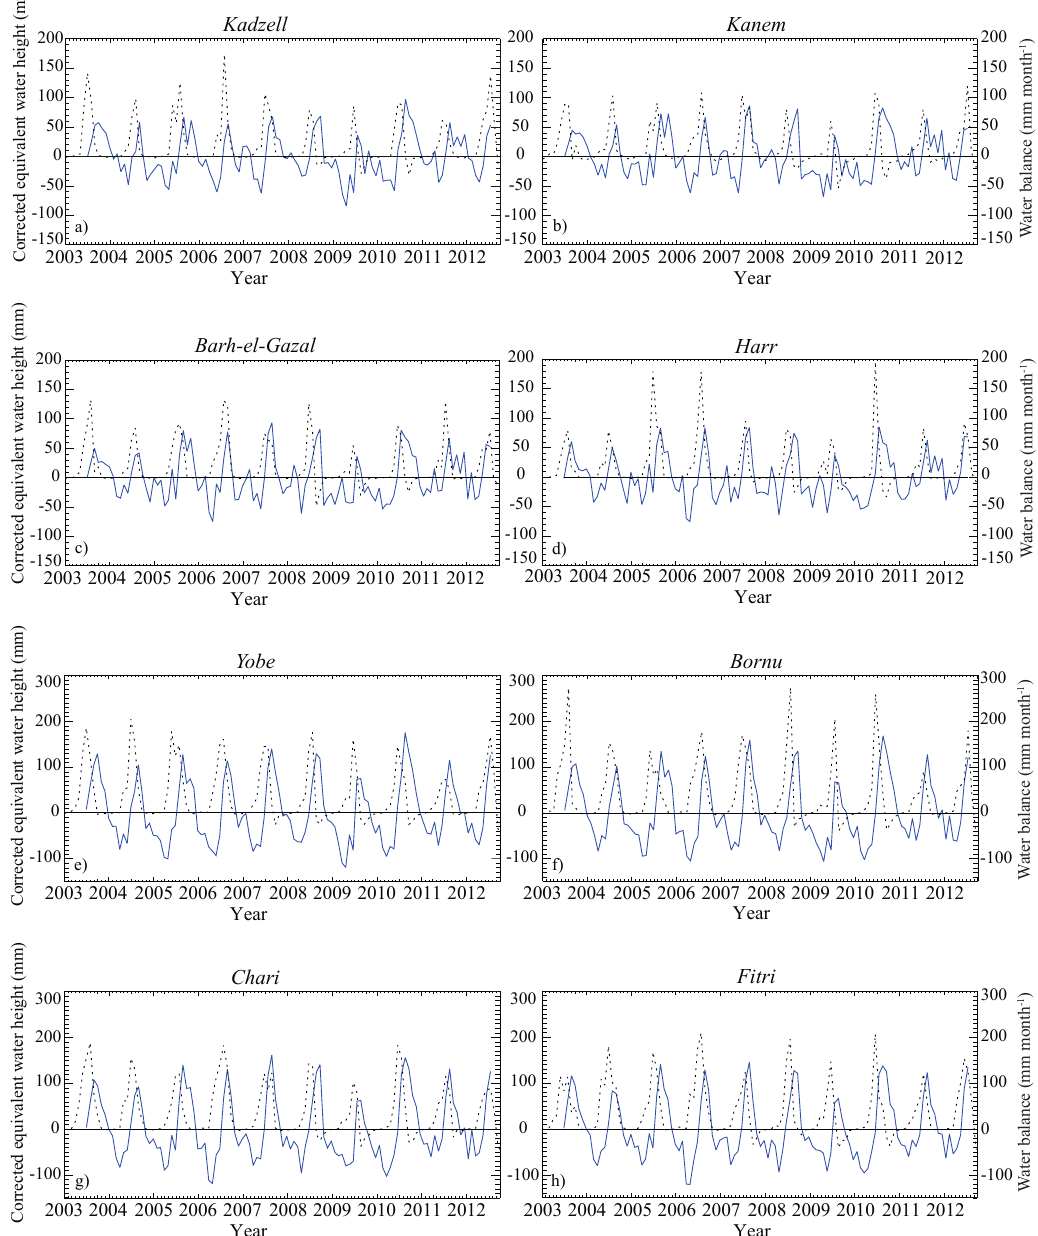
Figure 8. Each plot displays the monthly averaged GRACE water mass estimation (solid line), while the dashed line represents the water balance (TRMM precipitation-MODIS ET